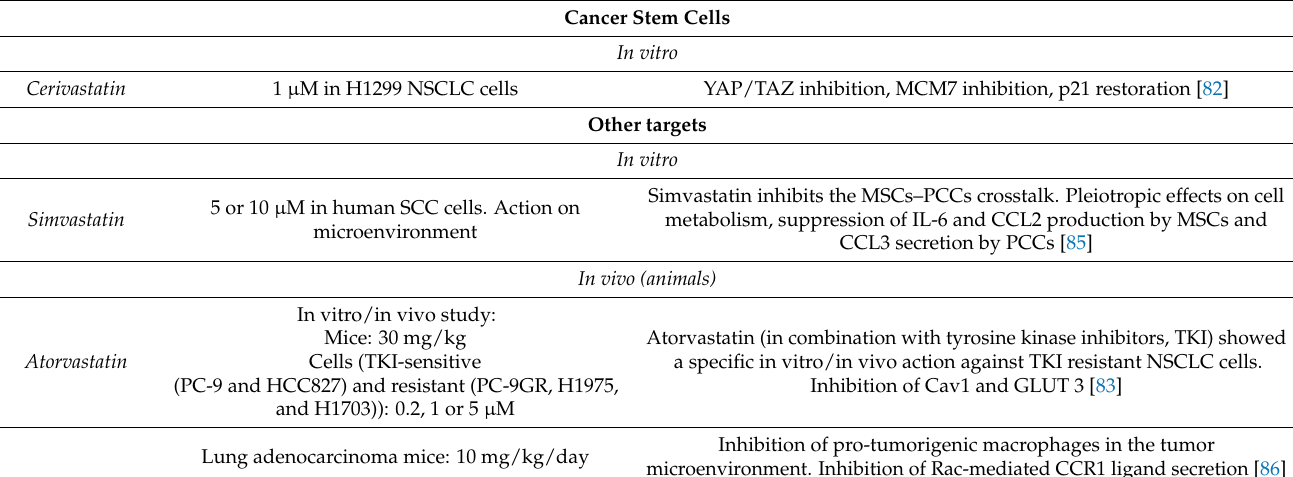
Table 7. Statins’ effects on lung cancer stem cells or other mechanisms.